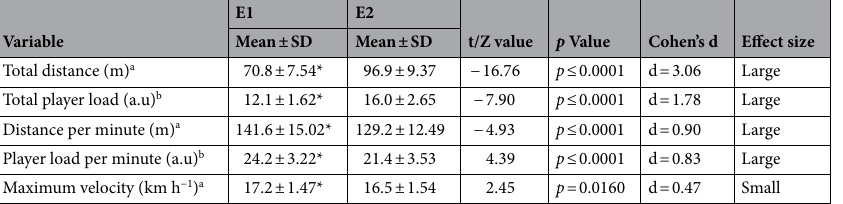
Table 3. Mean values of external load markers from six SSG bouts (mean ± SD) measured in both groups of tested youth soccer players. SSGs—small-sided games, E1—6 × 30 s 1 × 1 SSGs, E2—6 × 45 s 1 × 1